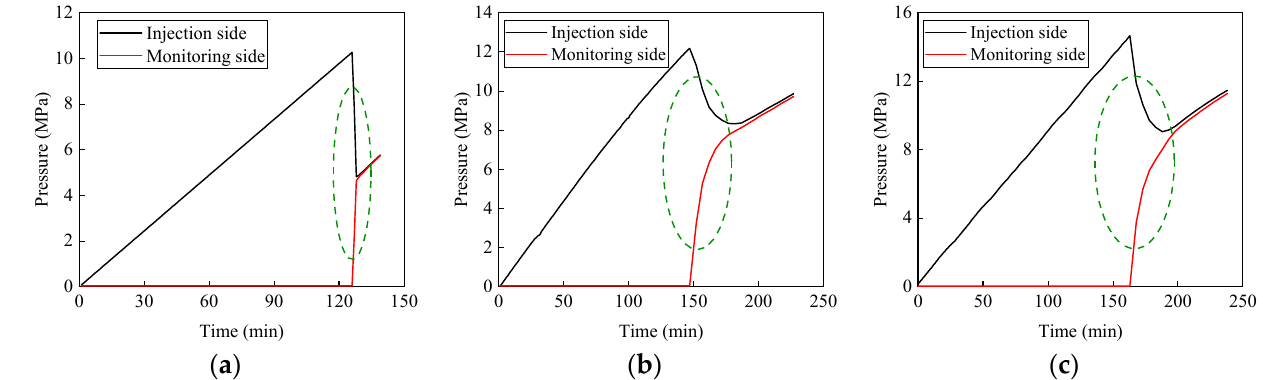
Figure 13. Sealing ability of the conventional cement sheath. ( a ) Cement sheath with 0% resin. ( b ) Cement sheath with 10% resin. ( c ) Cement sheath with 20% resin .